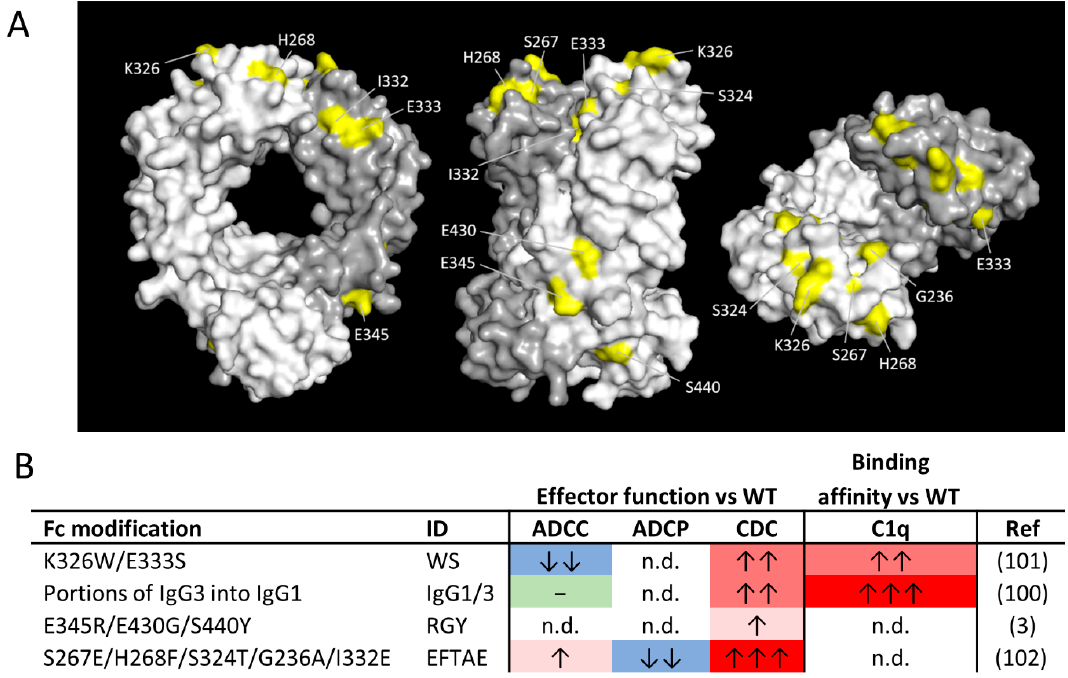
Figure 2. Fc modifications which increase complement-dependent cytotoxicity. ( A ) Previously identified point mutations within the Fc that modulate complement dependent cytotoxicity are annotated on a human IgG1 Fc crystal structure model (PDB: 3AVE; [49,50]). ( B ) Fold change in effector function or binding affinity to C1q in complement dependent cytotoxicity (CDC)-enhancing variants compared to wild type (WT) antibodies. Magnitude of effector function or binding affinity of variants were compared to WT antibodies of the same IgG isotype and F(ab) region. Each row depicts an independent experiment and therefore often independent methods, utilizing a different IgG backbone from a particular study as referenced in the last column. NB = no detectable binding, n.d. = no data, − = no change, ↑ <2 fold upregulation, ↑↑ 2–9.99 fold upregulation, ↑↑↑ 10–99.99 fold upregulation, ↓↓ 2–9.99 fold downregulation,.